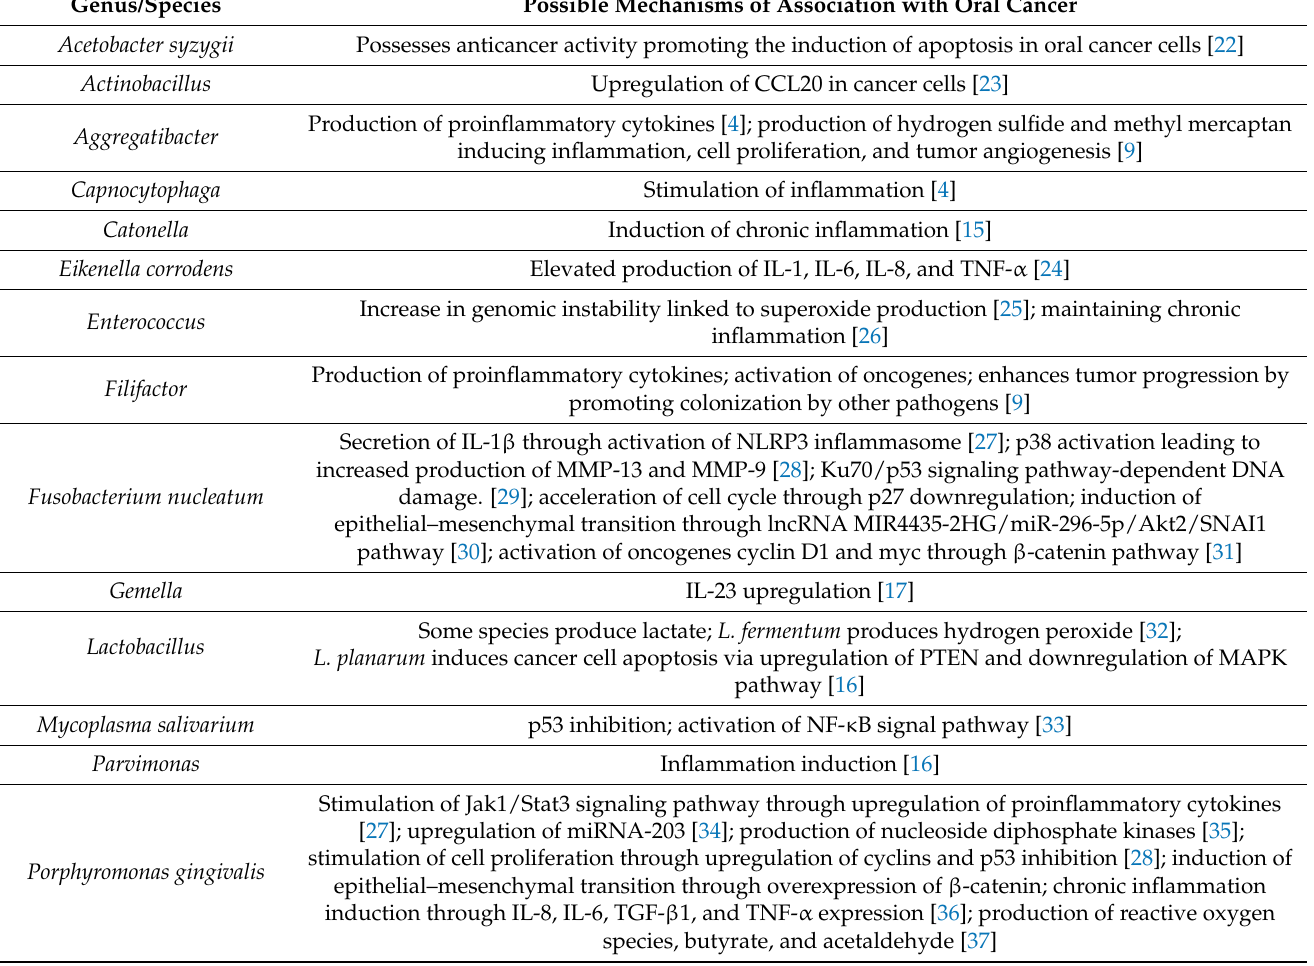
Table 1. Possible mechanisms of association between oral bacteria and oral cancer: in vitro studies performed on human samples.